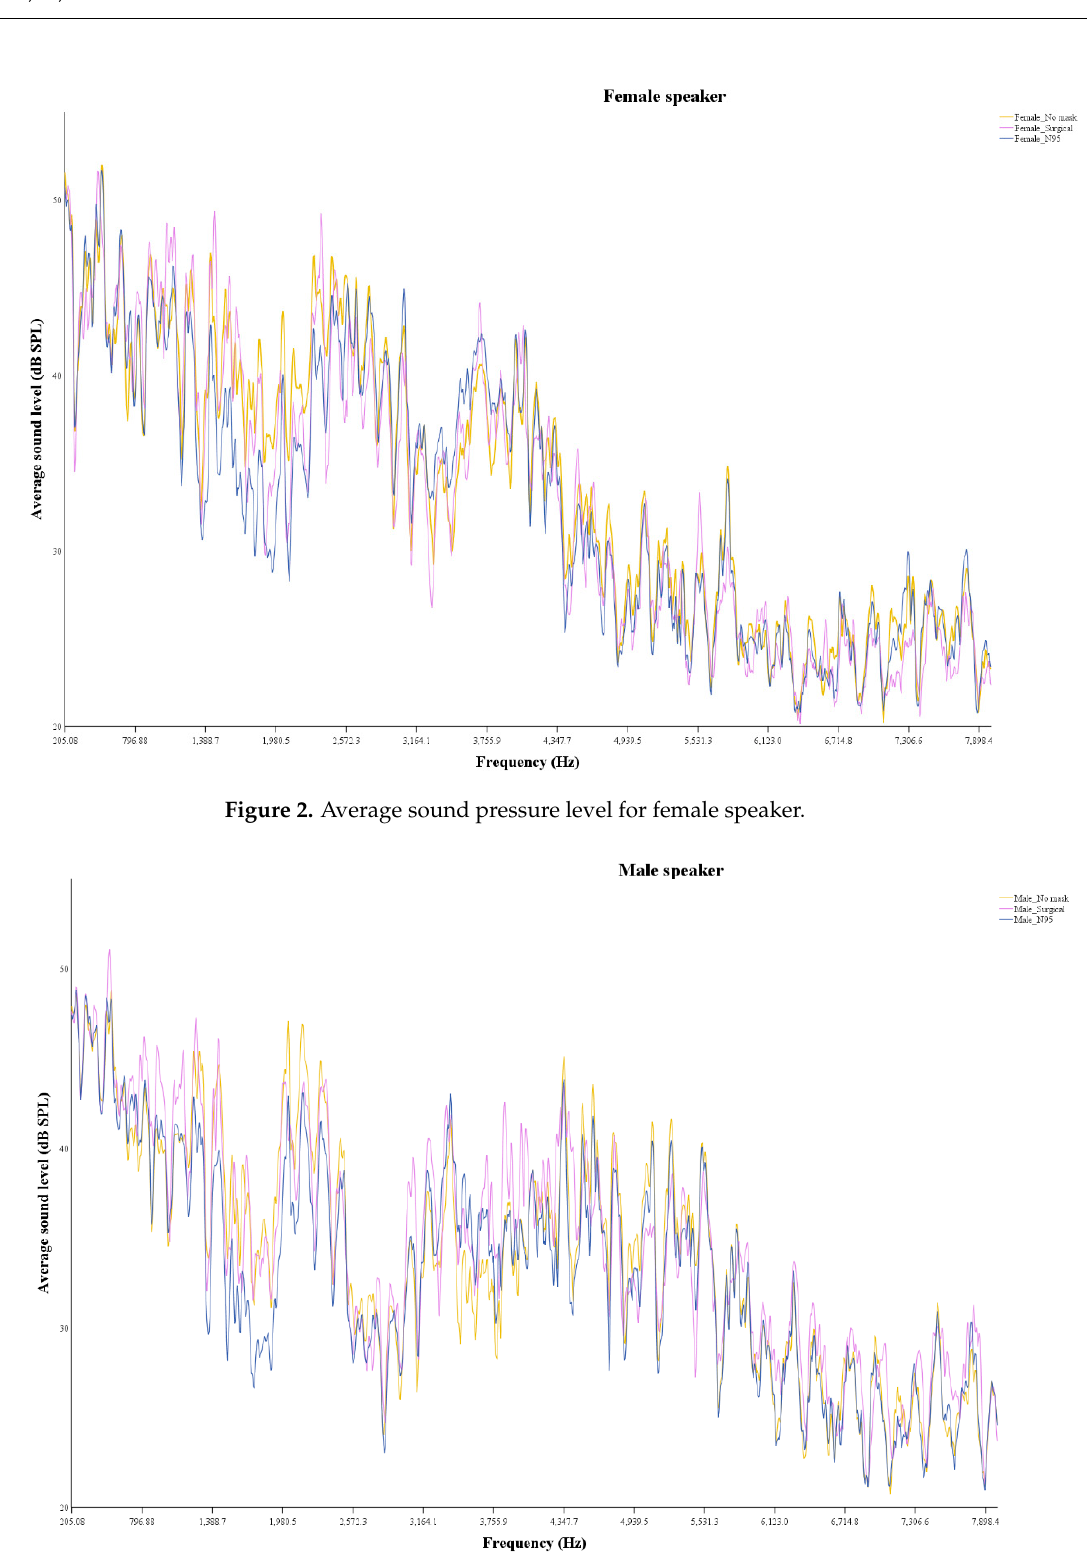
Table 1. Statistical analysis of the groups’ speech performance in the no visual cues and visual cues conditions (* p < 0.05). Group